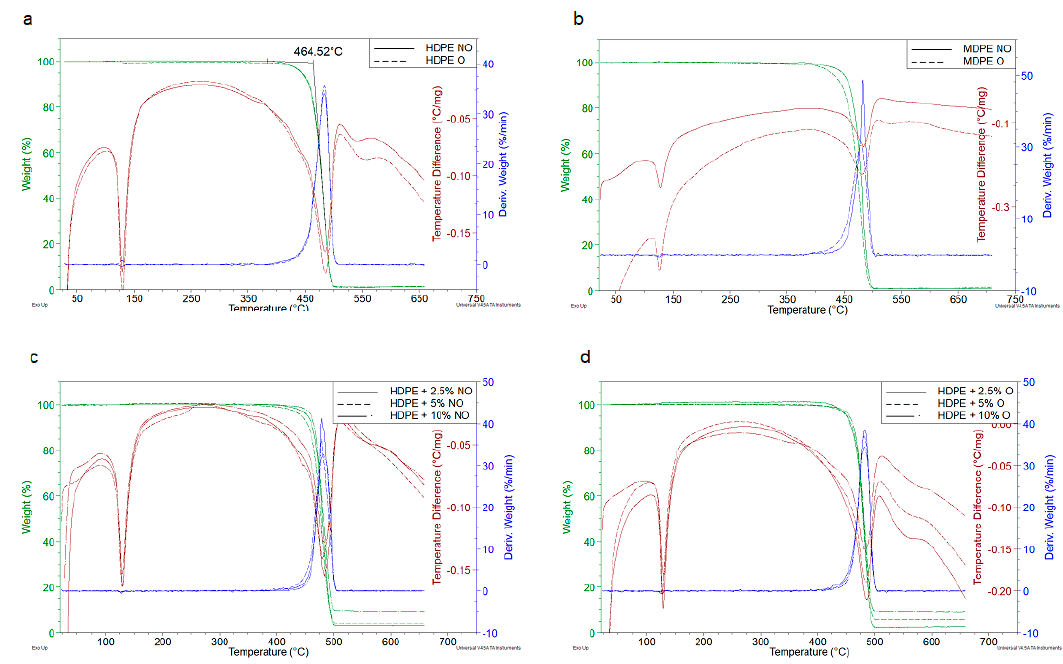
Figure 6. TG, DTG and DTA curves of PO and their composites: Effect of orientation on neat HDPE ( a ) and MDPE ( b ); non-oriented (NO) HDPE+Sillikolloid P87 ( c ), oriented (O) HDPE+Sillikolloid P87 ( d ). Table 3. Thermal parameters for non-oriented (NO) and oriented (O) HDPE, MDPE and their composites with Sillikolloid ( T o , temperature onset, T max , temperature at maximum process rate, ∆ m , weight loss at 600 °C, T m , melting temperature, V max , maximal rate of decomposition).